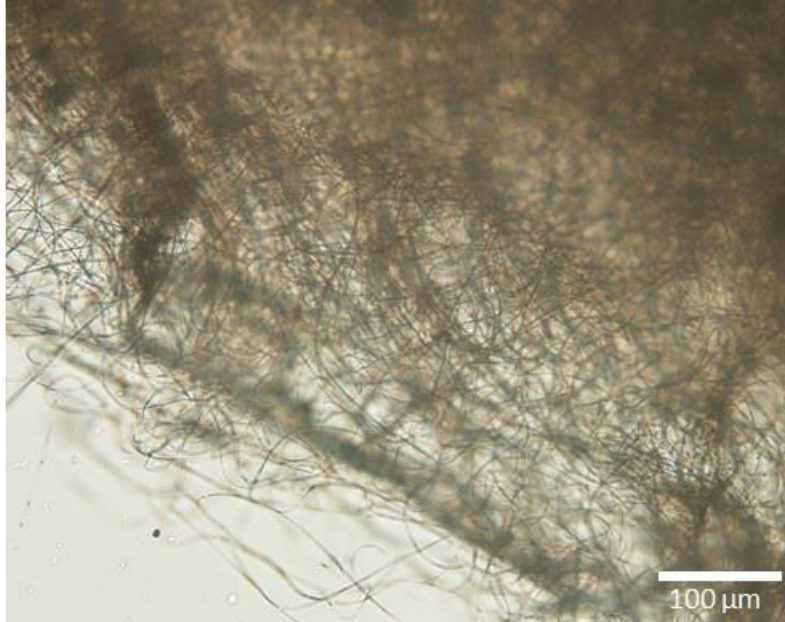
Figure 7. Optical microscope image of electrospun cellulose acetate nanofibers.